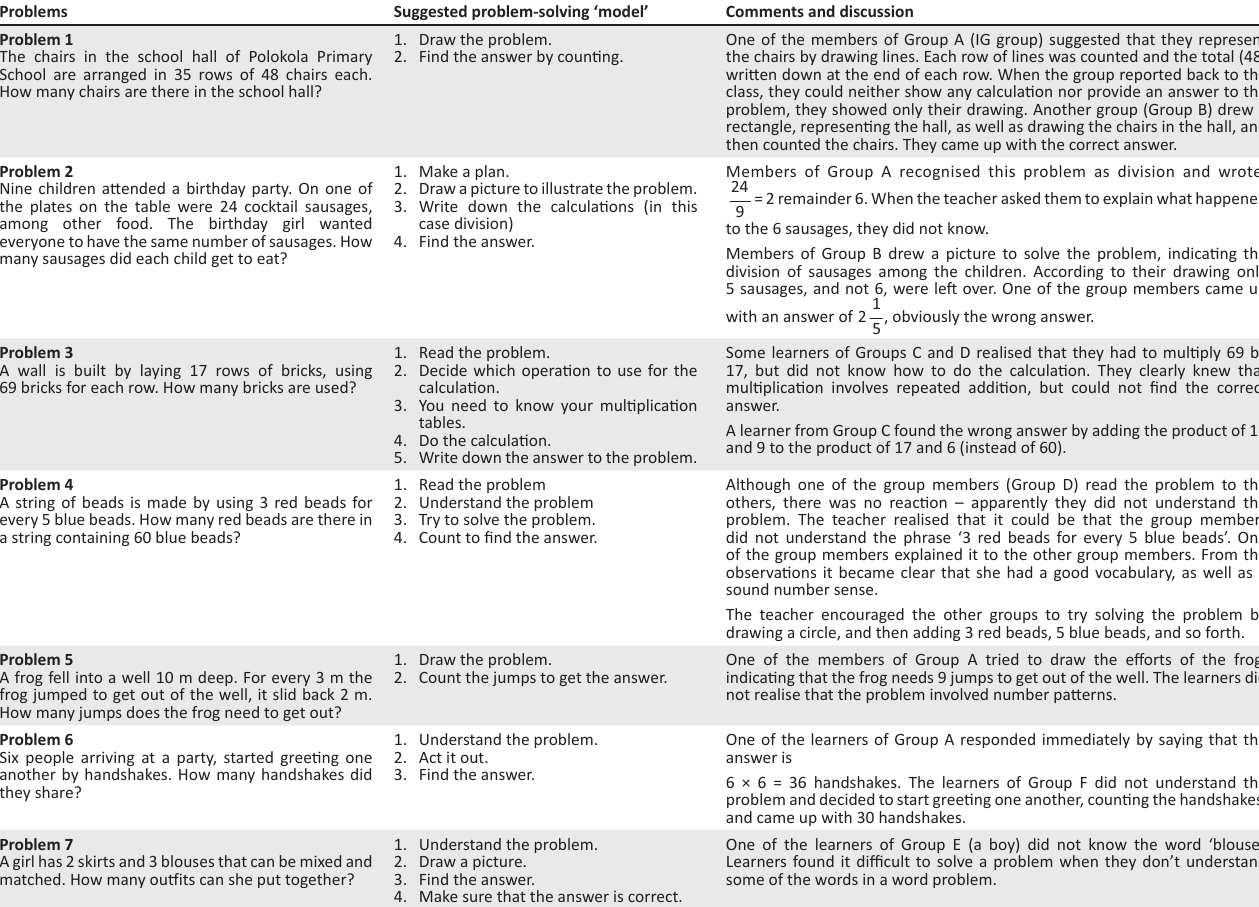
TABLE 1: Summary of different groups’ efforts towards a problem-solving model. Problems Suggested problem-solving